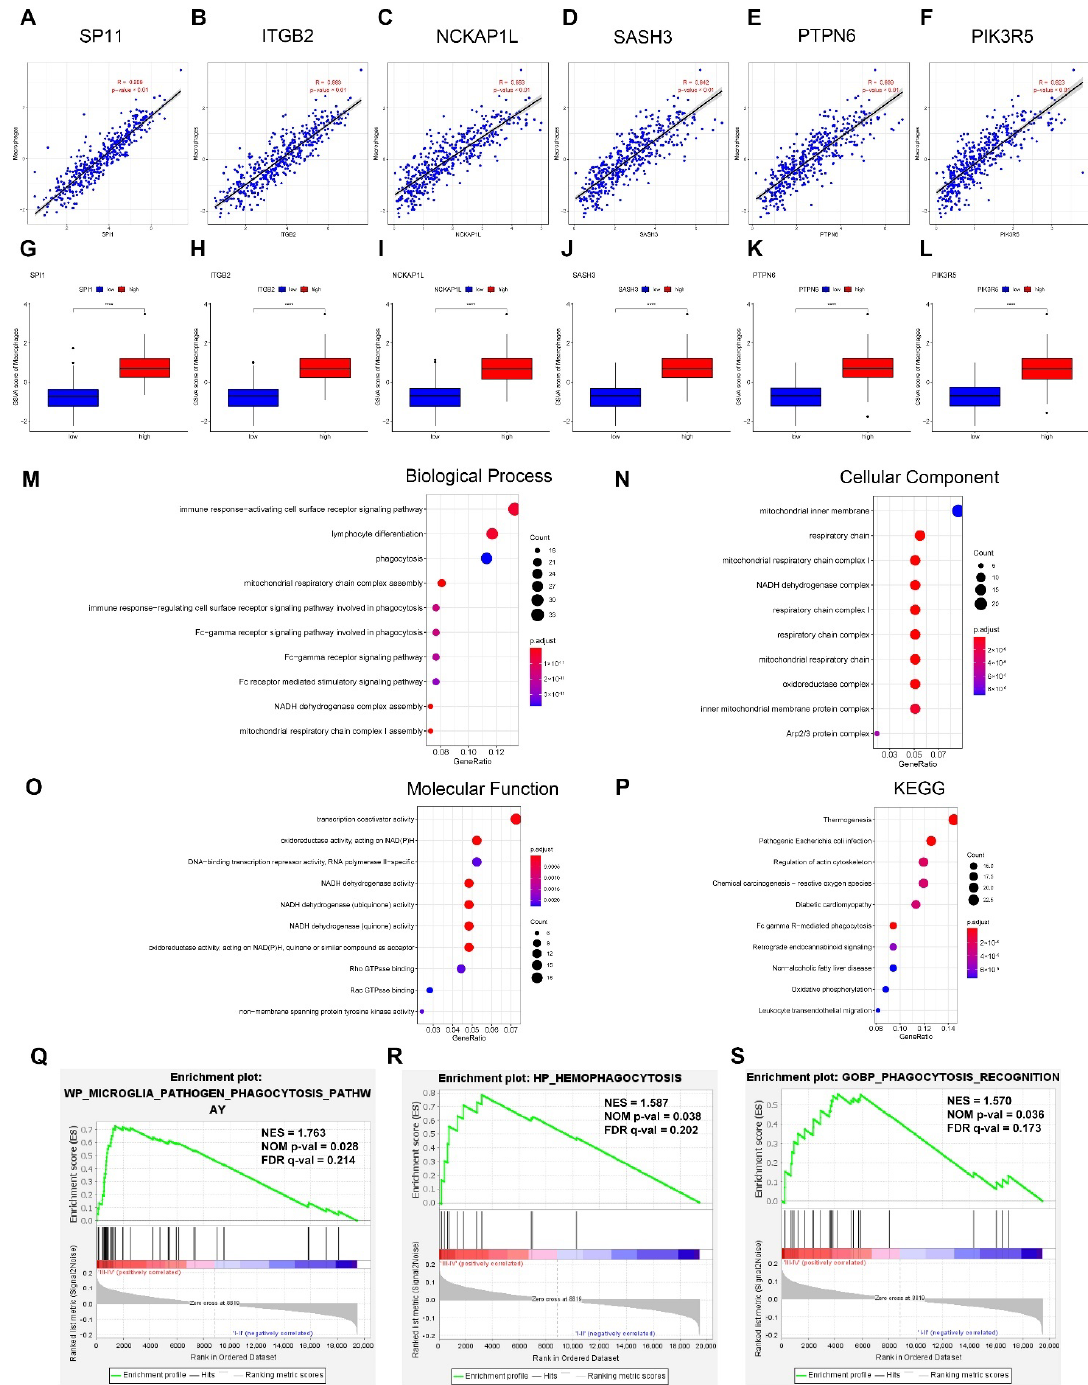
Figure 2. Phagocytosis regulators regulate the involvement of macrophages in tumor development. ( A – L ) Phagocytosis regulators regulate macrophage phagocytosis. ( A – F ) Pearson correlation of phagocytosis regulators with macrophage enrichment scores (Top6). We obtained 260 phagocytosis regulators with expression information from the relevant literature and then calculated their Pearson correlations with macrophage enrichment scores. We took the six with the strongest correlations ( A – F : SP11, ITGB2, NCKAP1L, SASH3, PTPN6, PIK3R5) to plot scatter plots (all p -values < 0.01